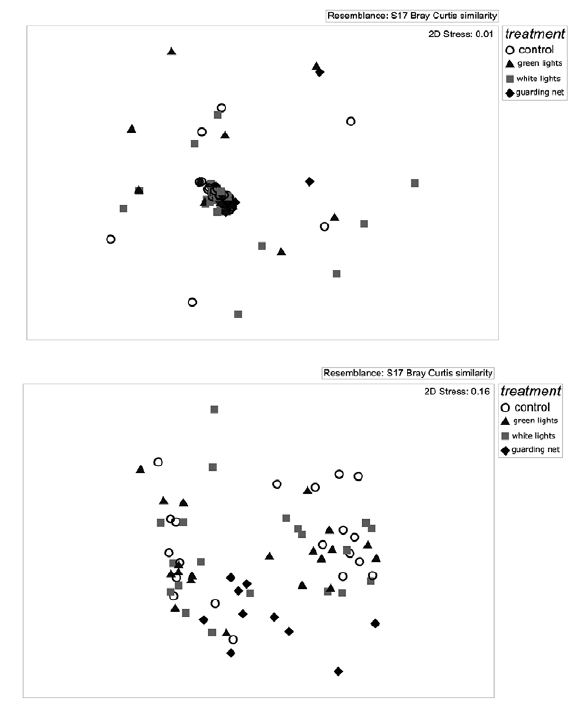
Fig. 6. – Non-metric multidimensional scaling (nMDS) of catch composition. TOP, species composition of unwanted catches; BOT- TOM, species composition of the commercial